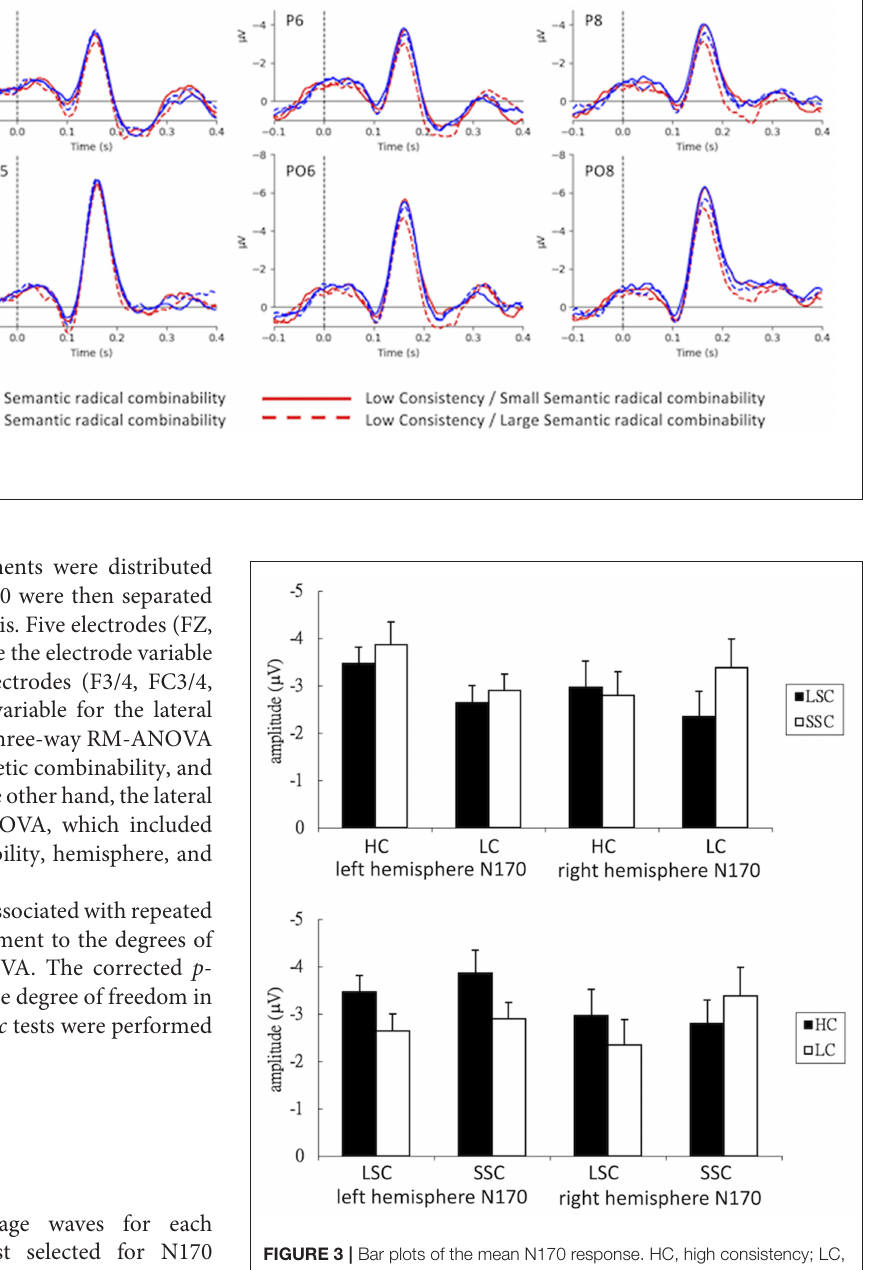
FIGURE 3 | Bar plots of the mean N170 response. HC, high consistency; LC, low consistency; LSC, large semantic radical combinability; SSC, small semantic radical combinability; left, left hemisphere; right, right